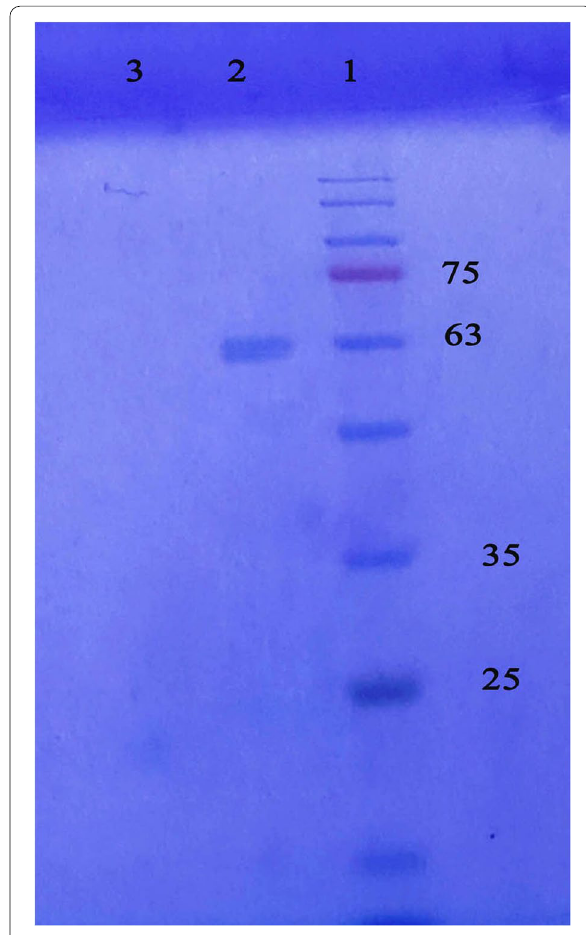
Fig. 8 The HN protein was purified by chromatography. Lane 1: marker weight (#SL7001-Sinaclon, Iran). Lane 2: purified HN protein (63 kD). Lane 3: negative control (culture